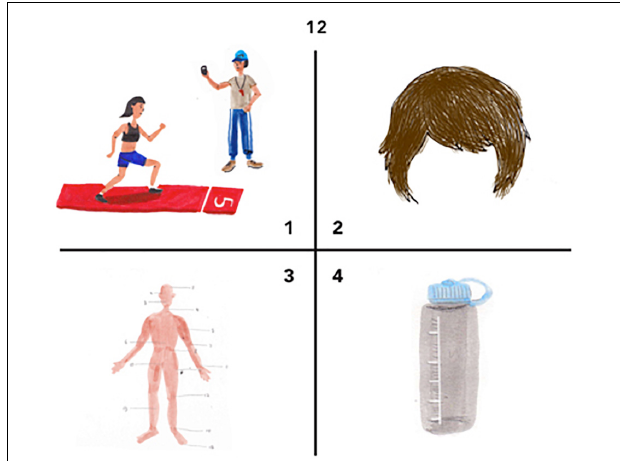
FIGURE 2 | Example of an item from ACCE-V. The target word is body. The body is depicted using a traditional schematization of the body as often used in the context of Traditional Chinese